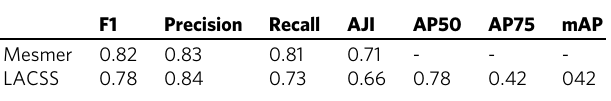
The results from the Mesmer model (fully-supervised) are shown for